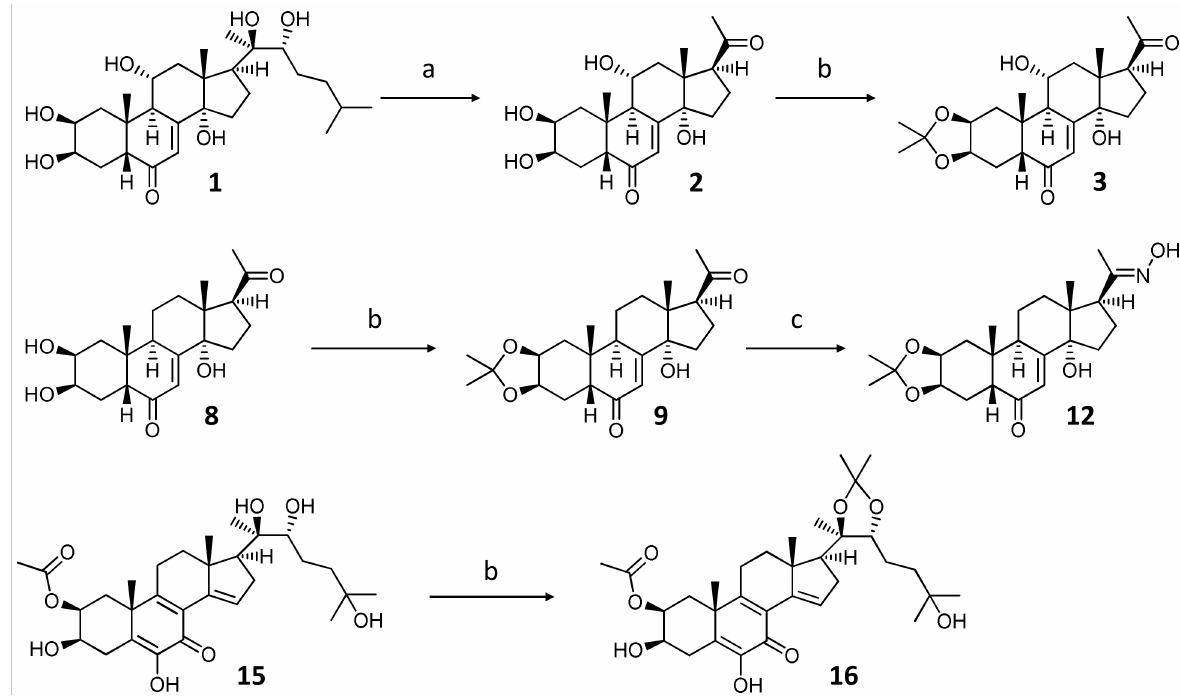
Figure 1. Semi-synthetic transformations of ajugasterone C ( 1 ), poststerone ( 8 ), and calonysterone 2-acetate ( 15 ). Reagents and conditions: ( a ) PIDA, methanol, RT, 60 min; ( b ) PMA, acetone, RT, 30 min; ( c ) NH 2 OH · HCl, KOH, EtOH, RT, 24